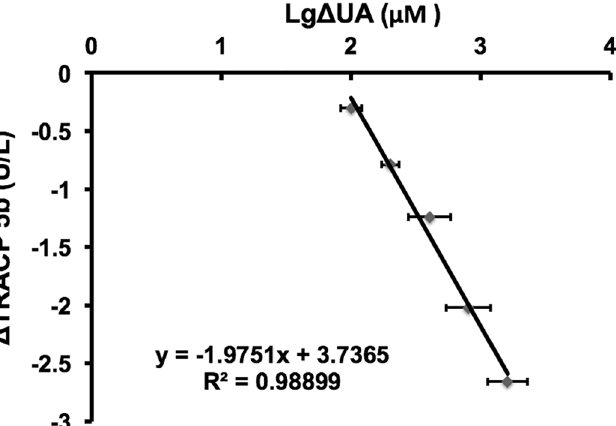
Fig 3. Derivation of a UA correction equation. The TRACP 5b concentrations of the six distinct test samples with the same TRACP 5b standard sample and final UA concentrations ranging from 0 to 1600 μ M were measured. Δ TRACP 5b means difference of TRACP 5b concentrations measured between the samples of final UA concentrations ranging from 100 to 1600 μ M and that of no UA. The average Δ TRACP 5b concentration is marked in figure with error bars representing standard deviations.